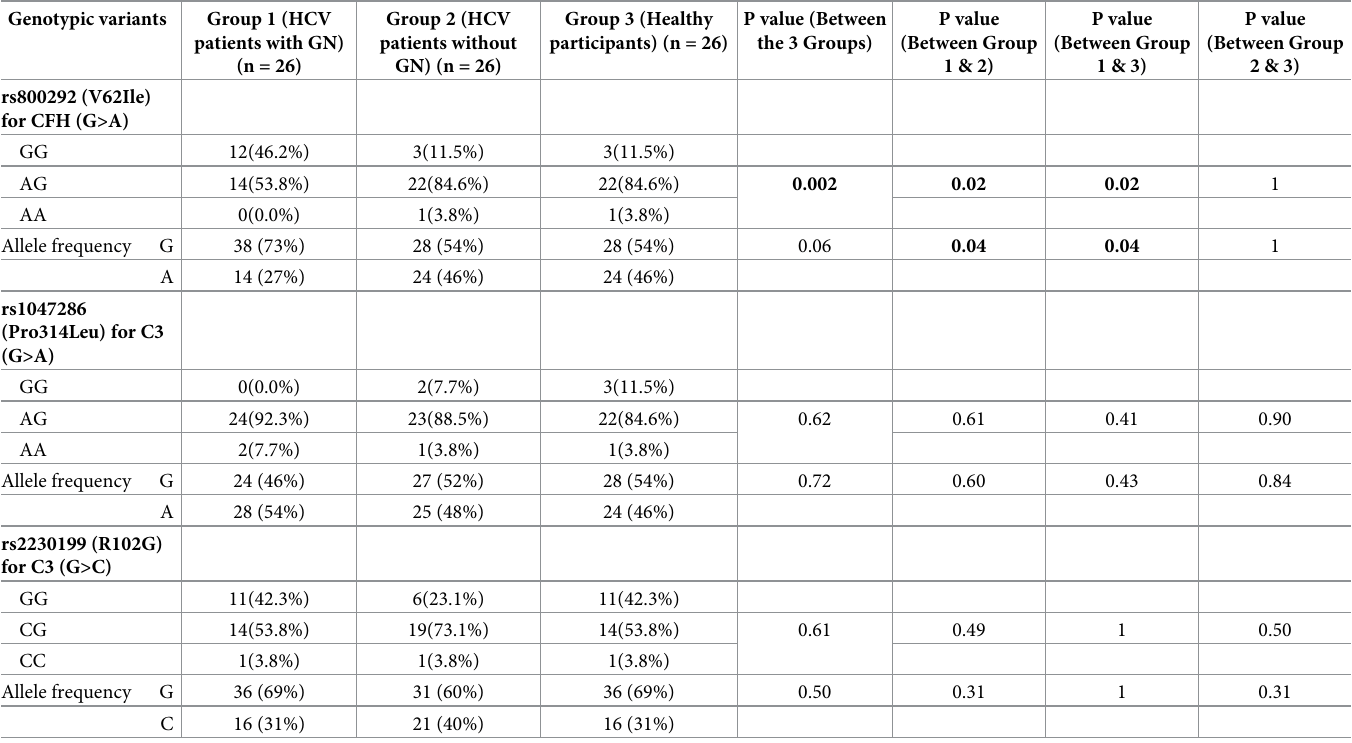
Table 3. Comparison between the groups according to genotype variants and allele frequency of the studied SNPs. Genotypic